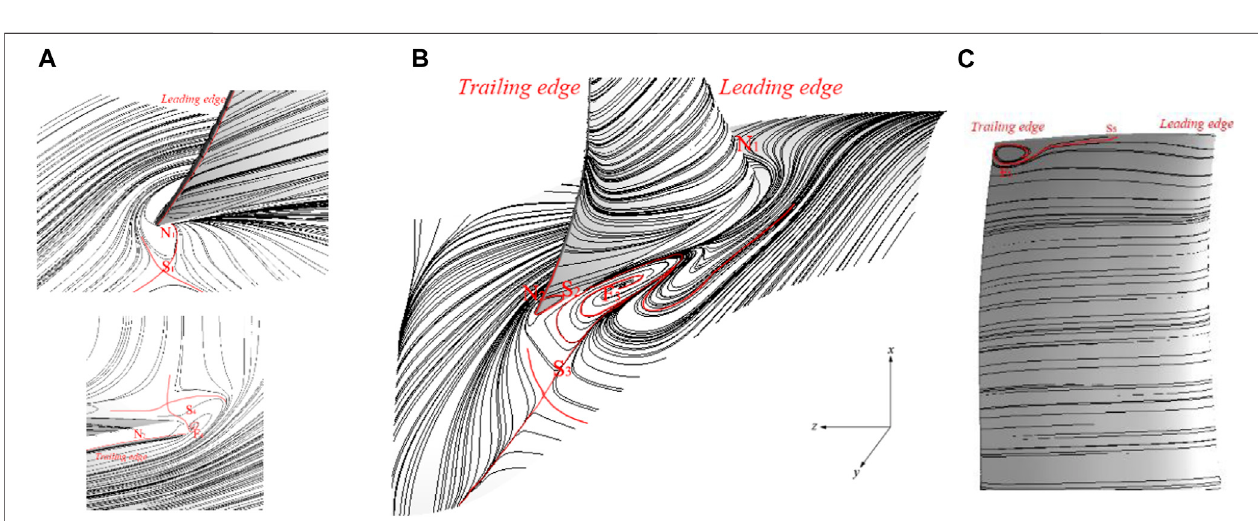
position, and saddle point S2 appears. The limit friction line terminates at the trailing edge of the blade, as shown in Figure 5A . The starting point of separation in this region is saddle point S2, and the separation terminates at tail edge node N2. As they are affected by the corner separation vortices, the larger separation vortices appear at the position where the suction surface streamline deviates, and the separation vortices form focus point F3 on the streamline at the hub.